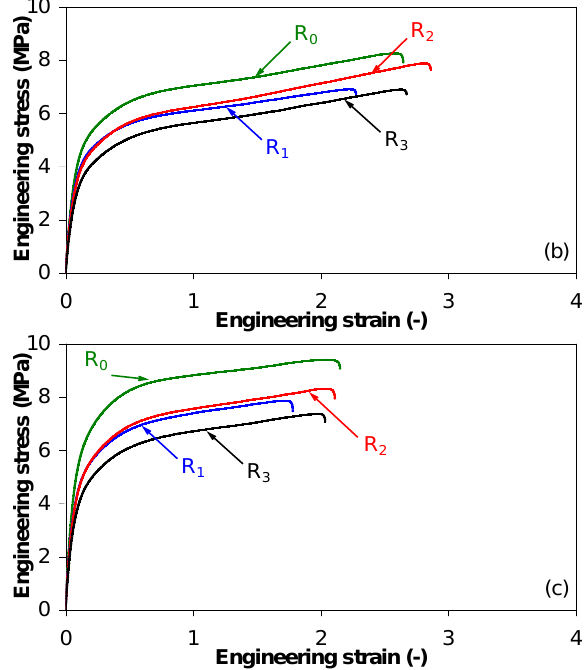
Figure 12. Effect of mechanical recycling on the stress-strain curves of the EVA/MWCNT nanocomposites with ( a ) 1 wt.%, ( b ) 3 wt.% and ( c ) 5 wt.% of MWCNTs at a crosshead displacement of 100 mm/min.